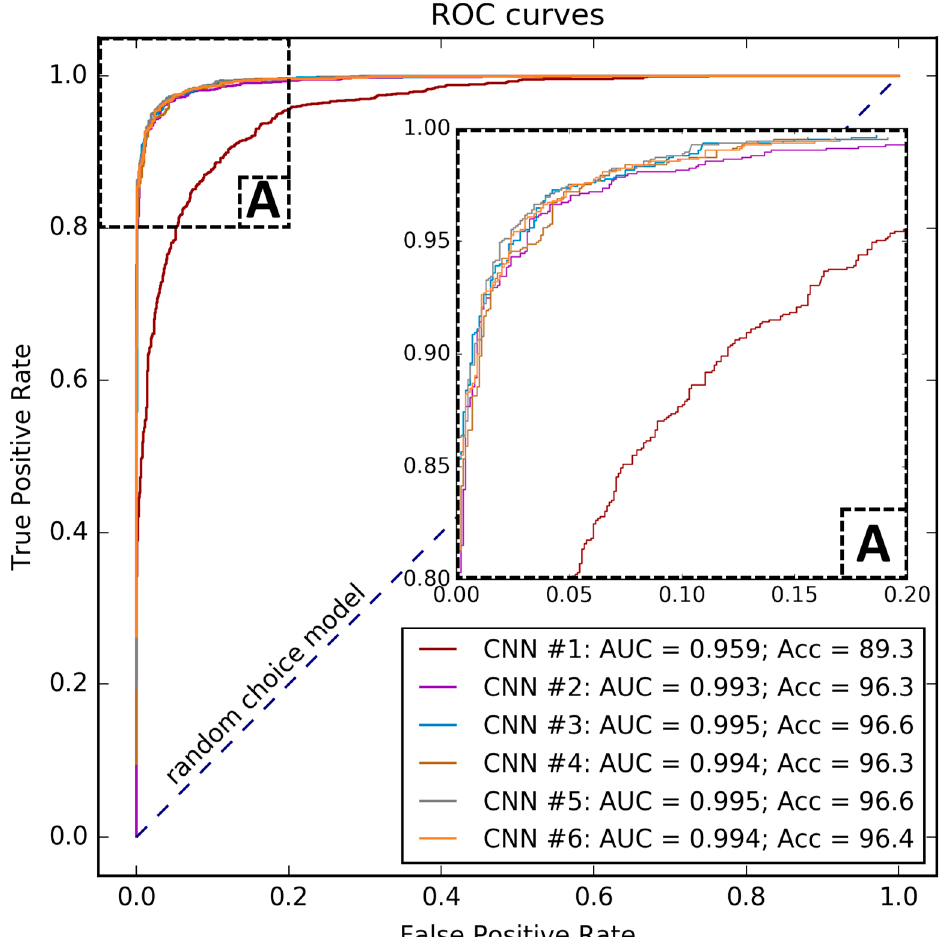
Figure A2. Receiver operating characteristic curves computed on test never-seen subset of data for all models. For each architecture the ensemble averaging technique is applied.